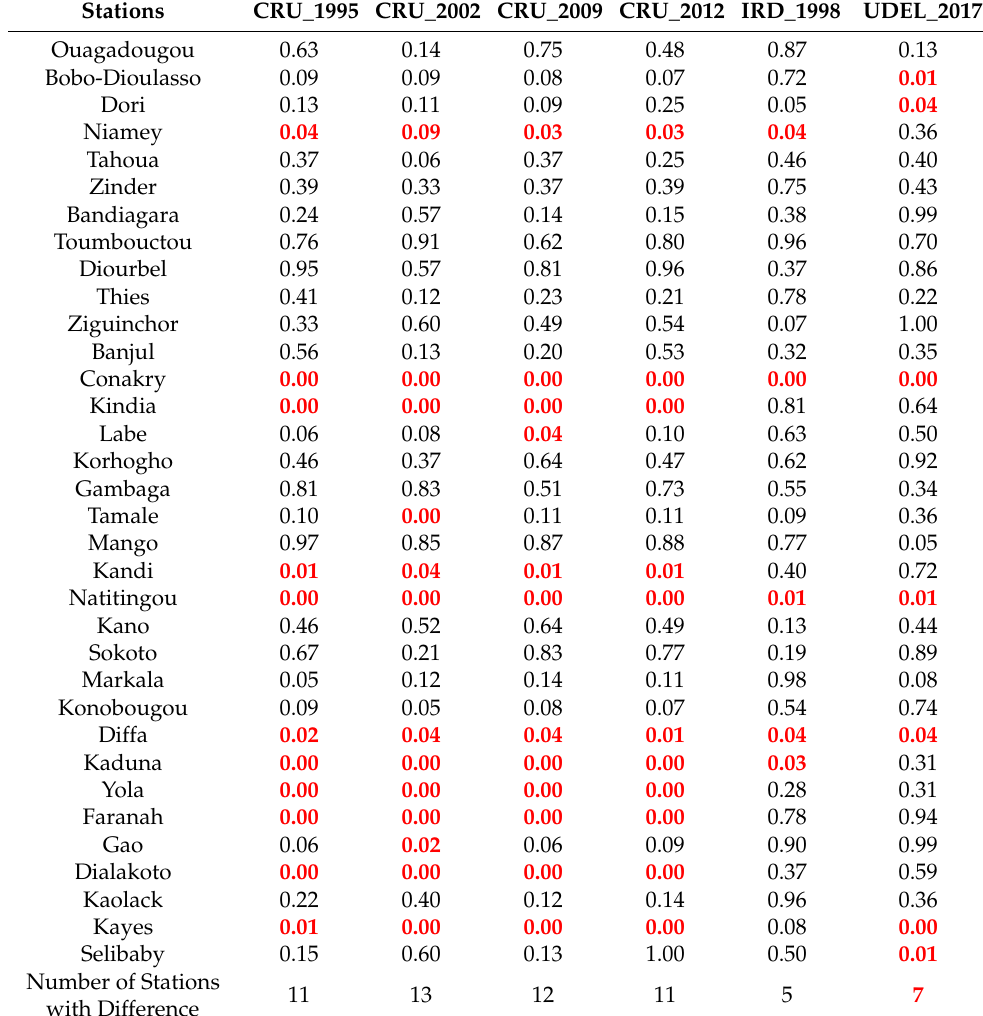
Table 1. Wilcoxon test p -values for the comparison between observations and gridded data.